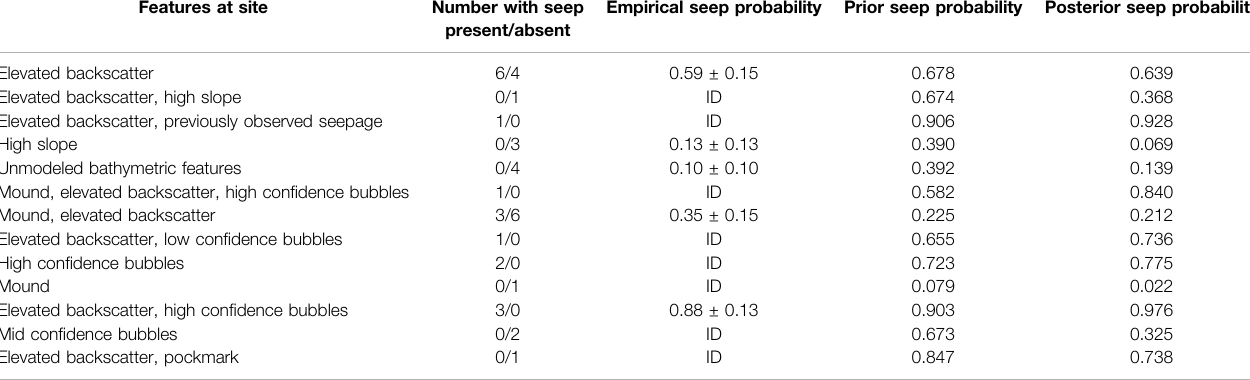
TABLE 4 | Seep presence and probabilities — Spock results.